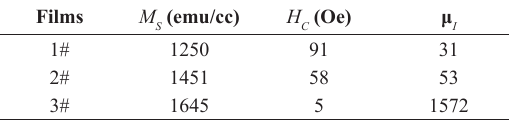
Table 3. Magnetic parameters of the iron nitride